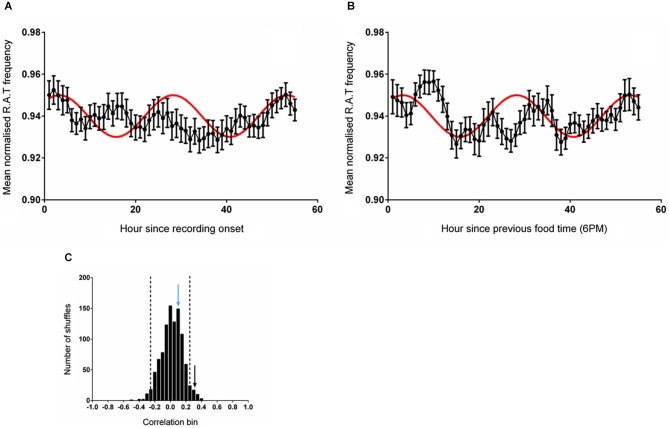
(A) The mean (±sem) normalized RAT frequency when food is given at hour 2 of recording and the data are referenced to the entry of the animal into the recording apparatus. (B) Illustrates the mean normalized RAT frequency when food is given at hour 2 of recording, but the data are referenced to the expected food time (6 pm). The frequency distribution produced by generating 1000 shuffled versions of the frequency dataset is illustrated in (C). The vertical dashed lines indicate two standard deviations from the mean of the distribution. The vertical black arrow represents the magnitude of the correlation of the data shown in (A) against the reference sine, while the vertical blue arrow represents the magnitude of the correlation of the data illustrated in (B) against the reference sine (shown in red).